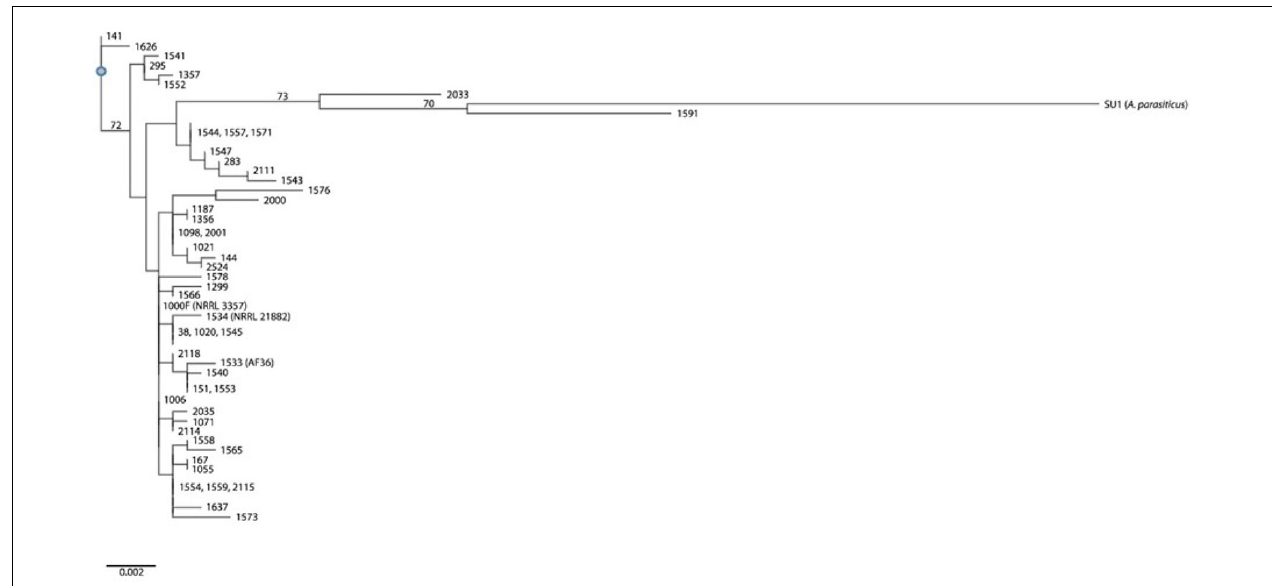
FIGURE 4 | Phylogenetic tree inferred for the A. flavus isolates examined in this study. Strain SU1 is the outgroup taxon, A. parasiticus . Phylogenetic inference is based on the concantenation of four unlinked genomic loci (amdS, benA, cmdA, and